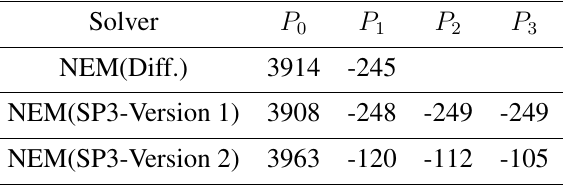
Table 1: C5G7 benchmark k in pcm by different